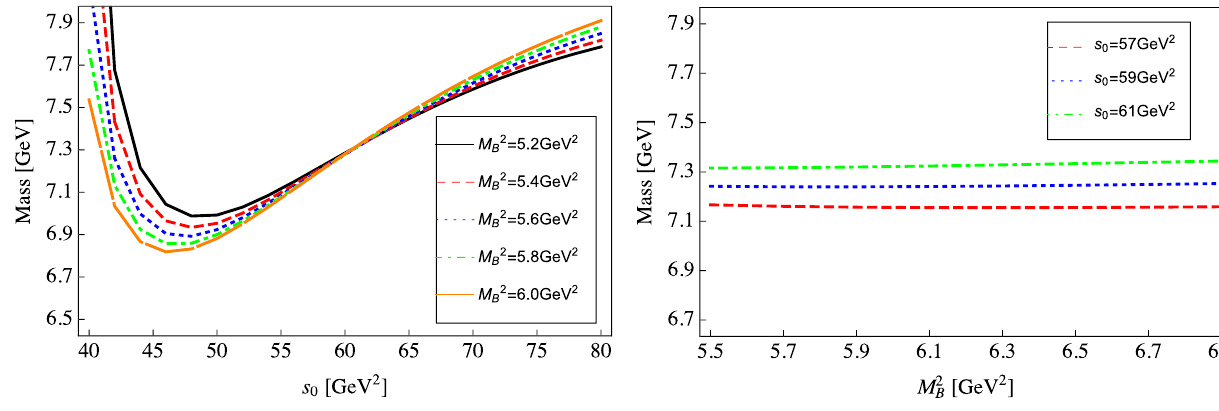
Fig. 2 Variation of m H with s 0 and M 2